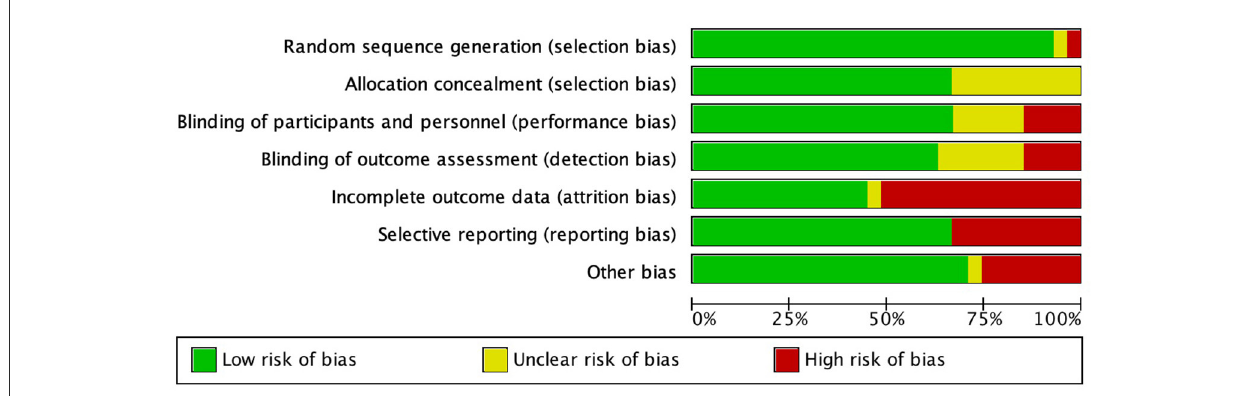
FIGURE2 Summary of risk of bias assessment for randomized controlled